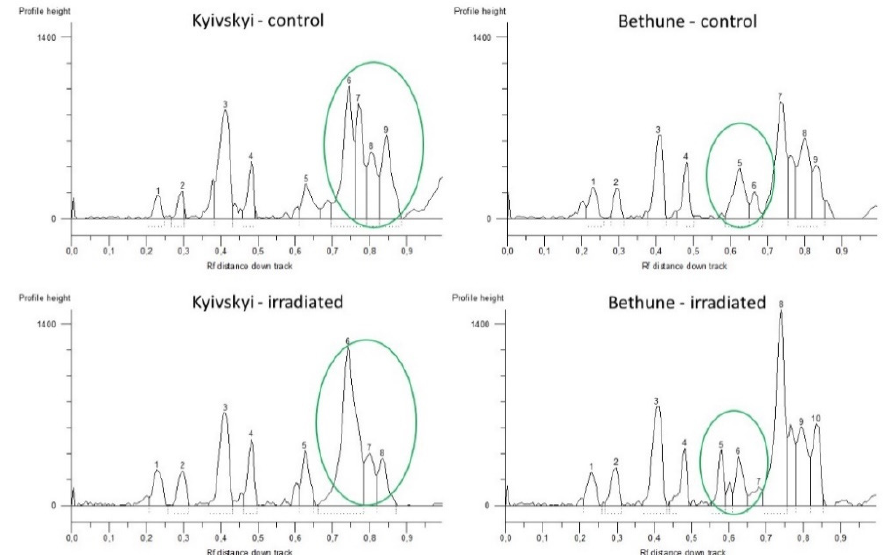
Figure 2. Comparison of obtained TRIM Cassandra profiles of common flax varieties Kyivskyi and Bethune grown in the remediated and radio-contaminated field conditions of Chernobyl. x axis—Rf distance down track; y axis—profile height. 1–10—numbering of the generated loci.